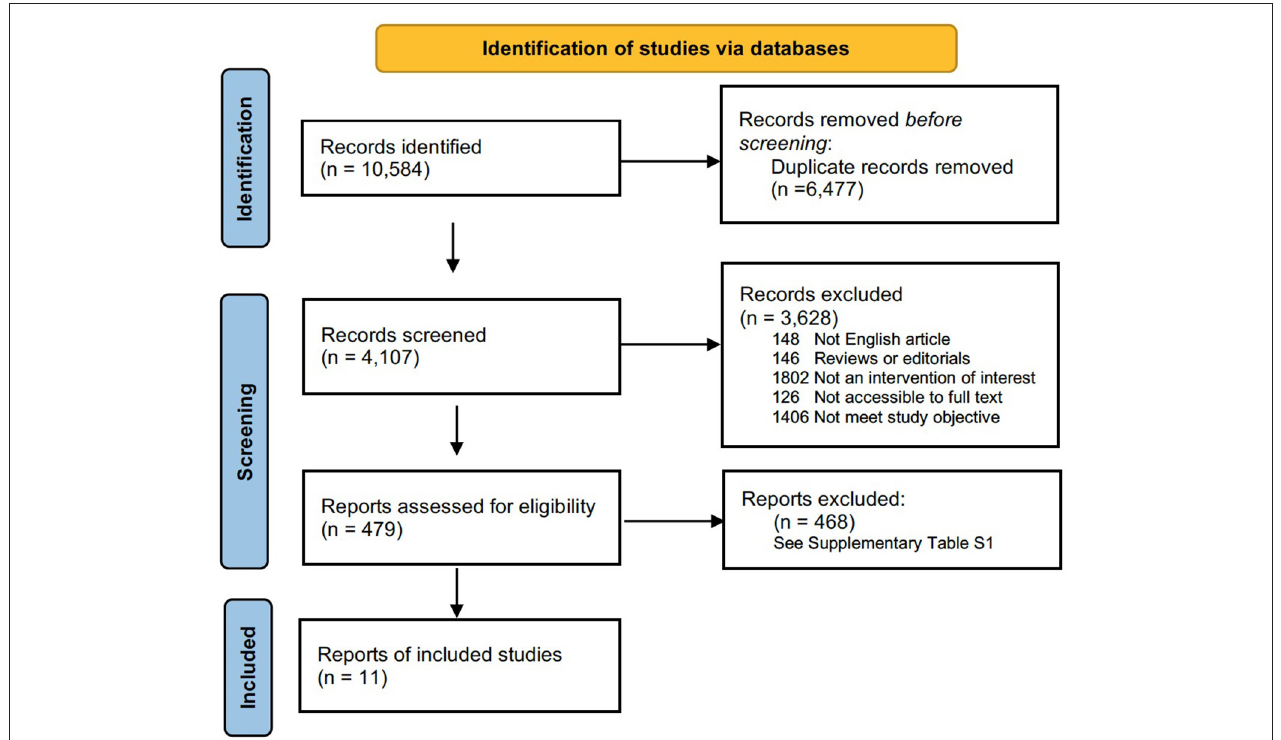
FIGURE 1 | Flow chart presenting the process of study selection for systematic reviews and meta-analysis.